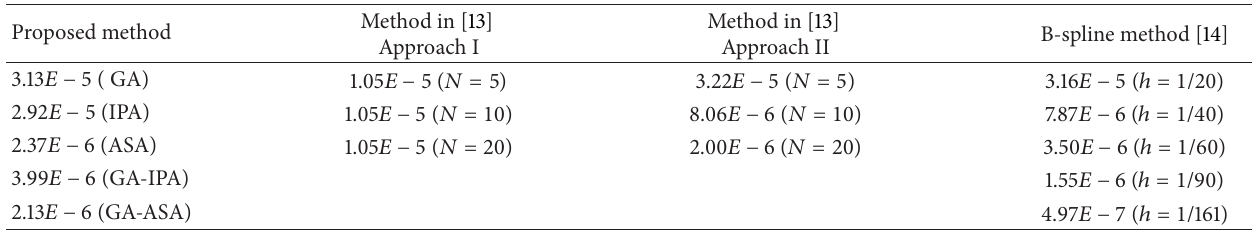
Table 5: Comparison of maximum absolute error for Example 1 between the proposed method and the methods given in [13, 14].